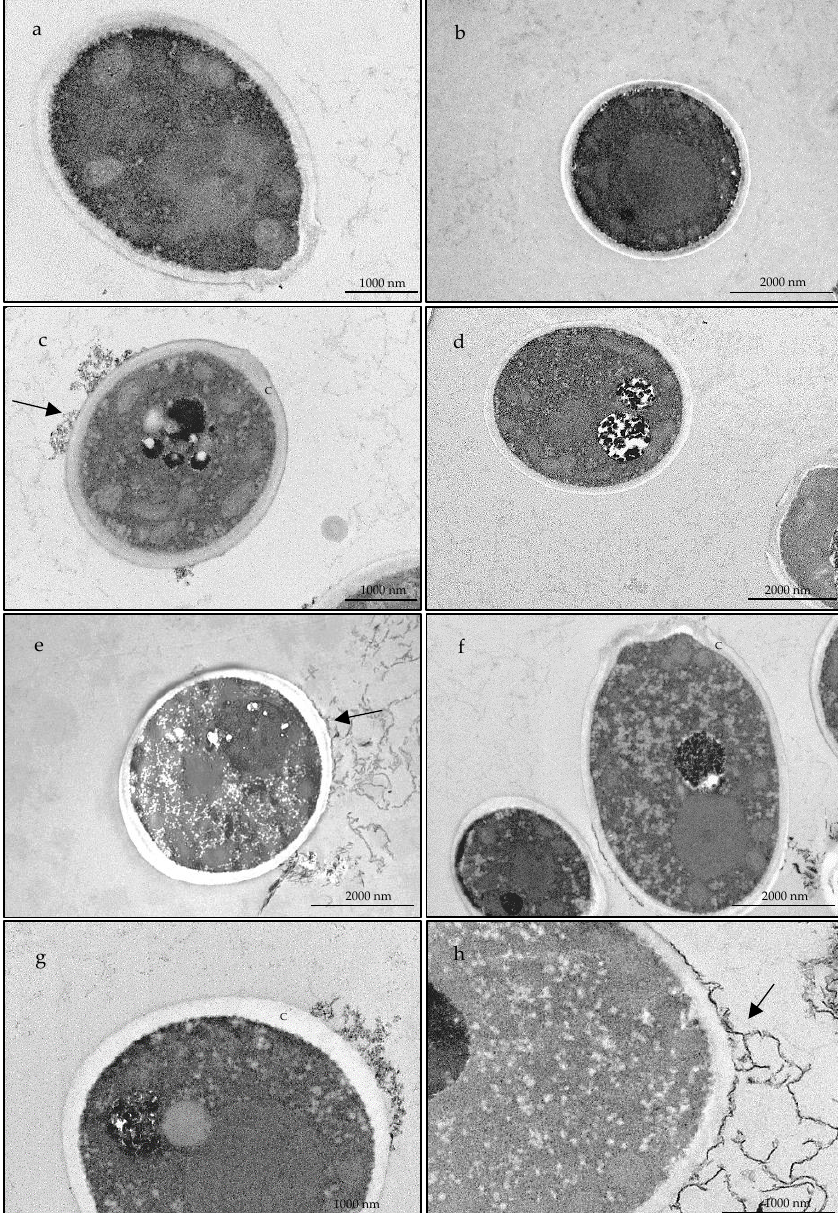
Figure 3. Transmission electron microscopic observations of Candida albicans in the presence of DMSO ( a , b ) or treated with of 72 µ g/mL of Bupleurum rigidum subsp. paniculatum essential oil ( c – h ). Arrow points to fragments from the cell wall; c—cell